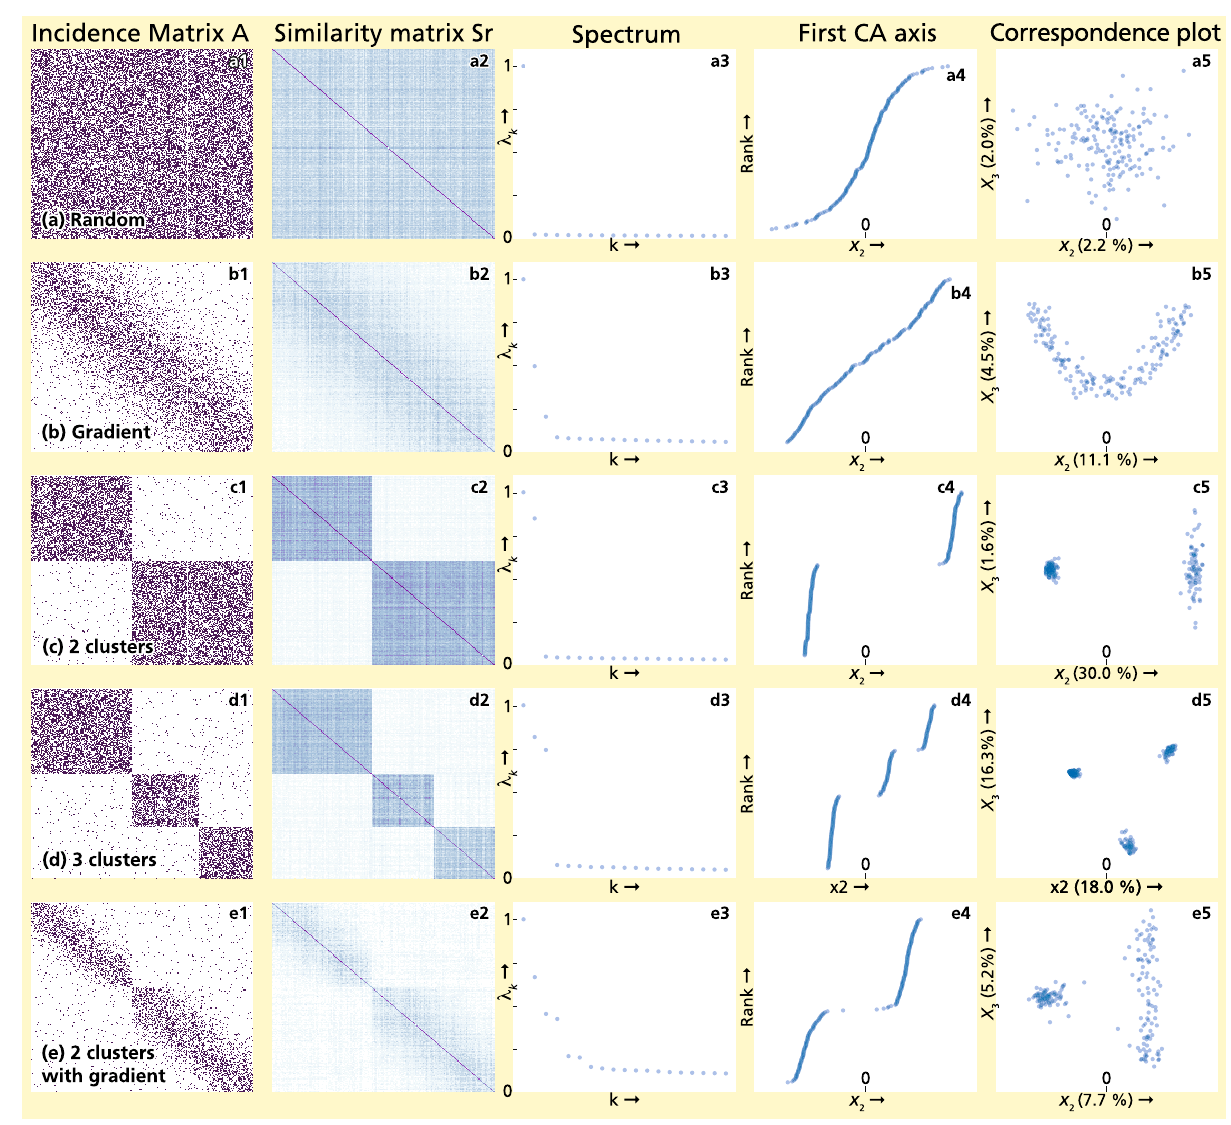
Figure 1. Stylized examples of five network structures and their corresponding spectra and eigenvalues. From top to bottom: a random bipartite network (a) , a network with a clear gradient (b) , a network consisting of two weakly connected clusters (c) , a network consisting of three weakly connected clusters (d) , and a network consisting of two weakly connected clusters containing a gradient (e) . From left to right: the n c n r similarity matrix S r describing pairwise similarities between the rows, the spectrum of the matrix A , the n r × first 20 eigenvalues, the first CA axis x 2 (dimension n r ), and the correspondence plot of the first and second CA axes x 2 and x 3 , respectively, with the percent variation explained for both